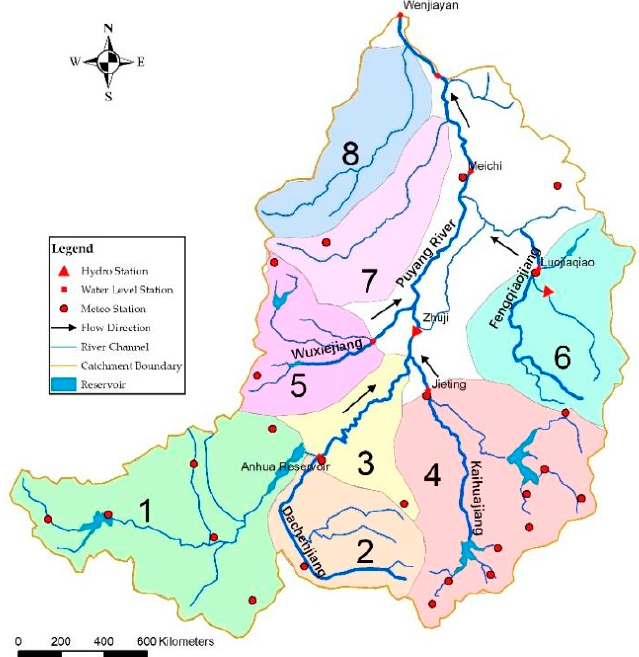
Figure 2. Hydrological division of the Puyang River catchment. (The division range of each sub- catchment in Figure 2: (1) the catchment of the Anhua Reservoir; (2) upstream catchment of the Longtan section of Dachenjiang River; (3) catchment between the Anhua Reservoir and Yajiayang; (4) upstream catchment of the Jieting water level station in Kaihuajiang River; (5) upstream catch- ment of the Shuimotou section of Wuxiejiang River; (6) upstream catchment of the Luojiaqiao sec- tion of Fengqiaojiang River; (7) the Huangtongjiang river catchment; (8) the Yongxing river catch- ment.).